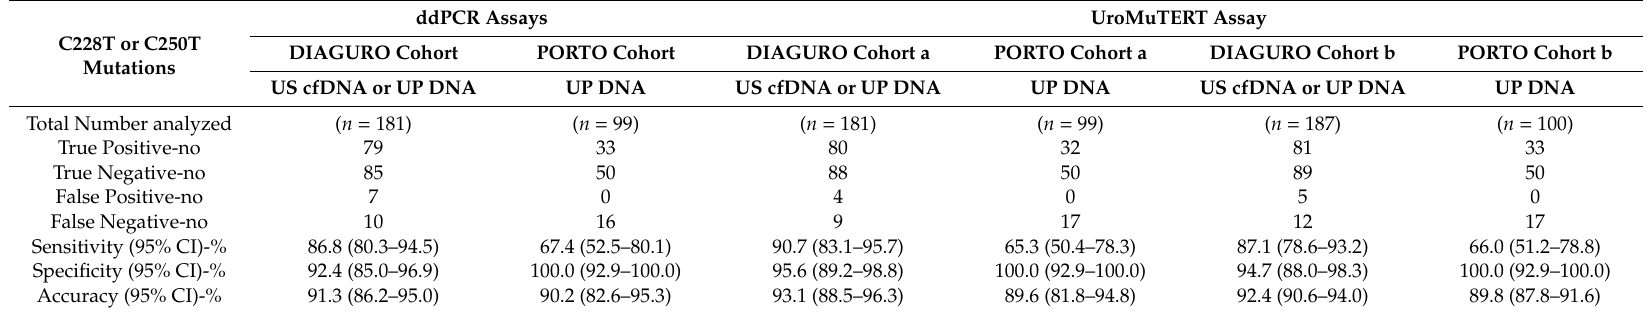
Table 1. Performance of urinary TERT promoter mutations in detecting UC by ddPCR and UroMuTERT Assays. ddPCR Assays UroMuTERT Assay C228T or C250T DIAGURO Cohort PORTO Mutations